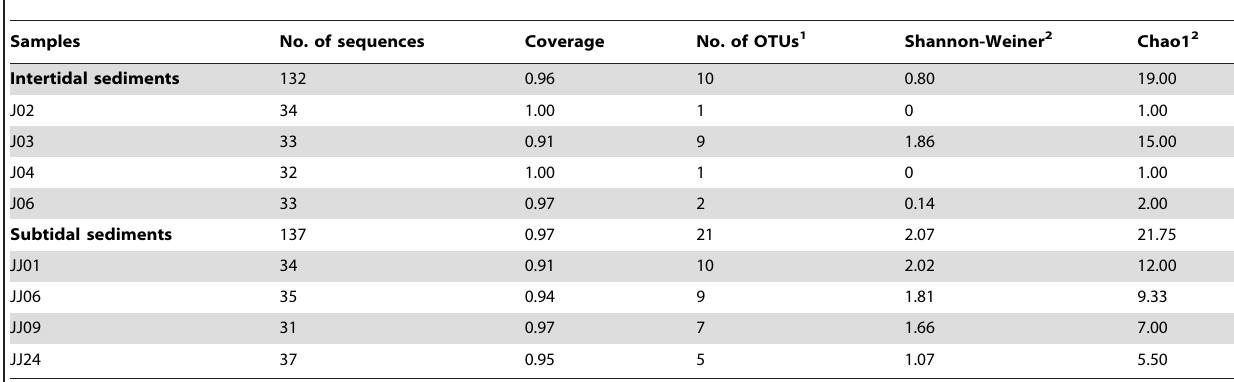
Table 5. Summary of the anammox bacterial diversity within the Jiaojiang Estuary.